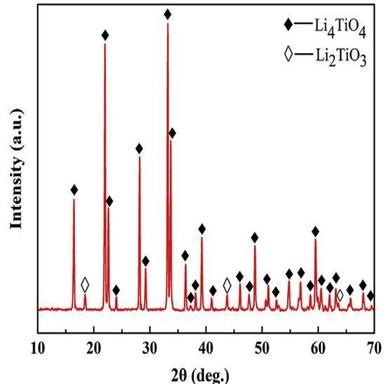
XRD patterns of the Li4TiO4-Li2TiO3 core-shell ceramic pebbles sintered at 750 -C for 4 h in vacuum.